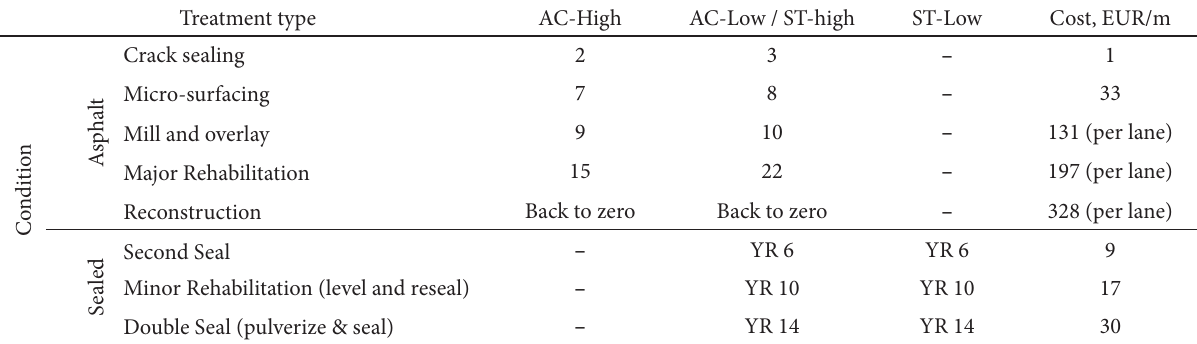
table 2. Treatment effectiveness for pavements (lifespan extension in years) and cost in